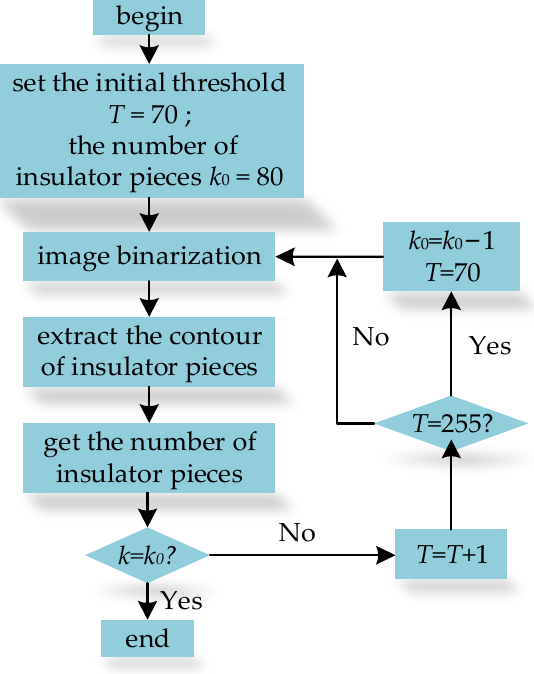
Figure 5. Dynamic adjustment of threshold value of image binarization.